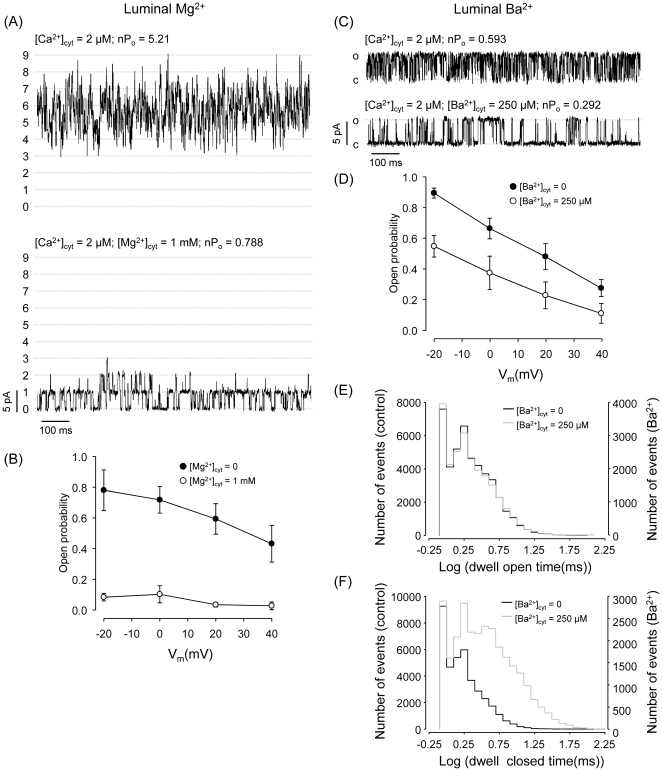
Effect of cytosolic Mg2+/Ba2+ on the behavior of RyR2 exposed to luminal Mg2+/Ba2+. (A)Multiple-channel recording of nine RyR2 exposed to 2 µM [Ca2+]cyt with 50 mM luminal Mg2+ as current carrier (Vm = 0 mV) before (top) and after (bottom) addition of 1 mM cytosolic Mg2+. (B) Chart summarizing mean open probabilities (± S.E.M.) as a function of holding voltage of channels bathed with luminal Mg2+ under the indicated cytosolic conditions (n = 9 experiments). (C) Single-channel recording of a RyR2 exposed to 2 µM [Ca2+]cyt with 50 mM luminal Ba2+ as current carrier (Vm = 0 mV) before (top) and after (bottom) addition of 250 µM cytosolic Ba2+. (D) Mean open probabilities (± S.E.M.) as a function of holding voltage of channels bathed with luminal Ba2+ before (filled circles) and after (open circles) addition of 250 µM cytosolic Ba2+ (n = 8 experiments). (E) Dwell open time distribution histograms of a single RyR2 exposed to luminal Ba2+ in the presence (grey outline) or absence (black outline) of 250 µM cytosolic Ba2+. Openings in the absence of cytosolic Ba2+ distributed with τo
1 = 1.61 ± 0.17 ms (85% events) and τo
2 = 6.18 ± 0.83 ms (15%). In the presence of cytosolic Ba2+, values were τo
1 = 1.09 ± 0.21 ms (70%) and τo
2 = 4.25 ± 0.36 ms (30%). (F) Dwell close time distribution histograms of RyR2 bathed with luminal Ba2+ before (black outline) and after (grey outline) addition of 250 µM cytosolic Ba2+. Closures in the absence of cytosolic Ba2+ distributed with τc
1 = 0.79 ± 0.24 ms (80% events) and τc
2 = 2.95 ± 0.57 ms (20%). In the presence of cytosolic Ba2+, values were τc
1 = 2.54 ± 0.12 ms (72%) and τc
2 = 13.37 ± 0.29 ms (28%)